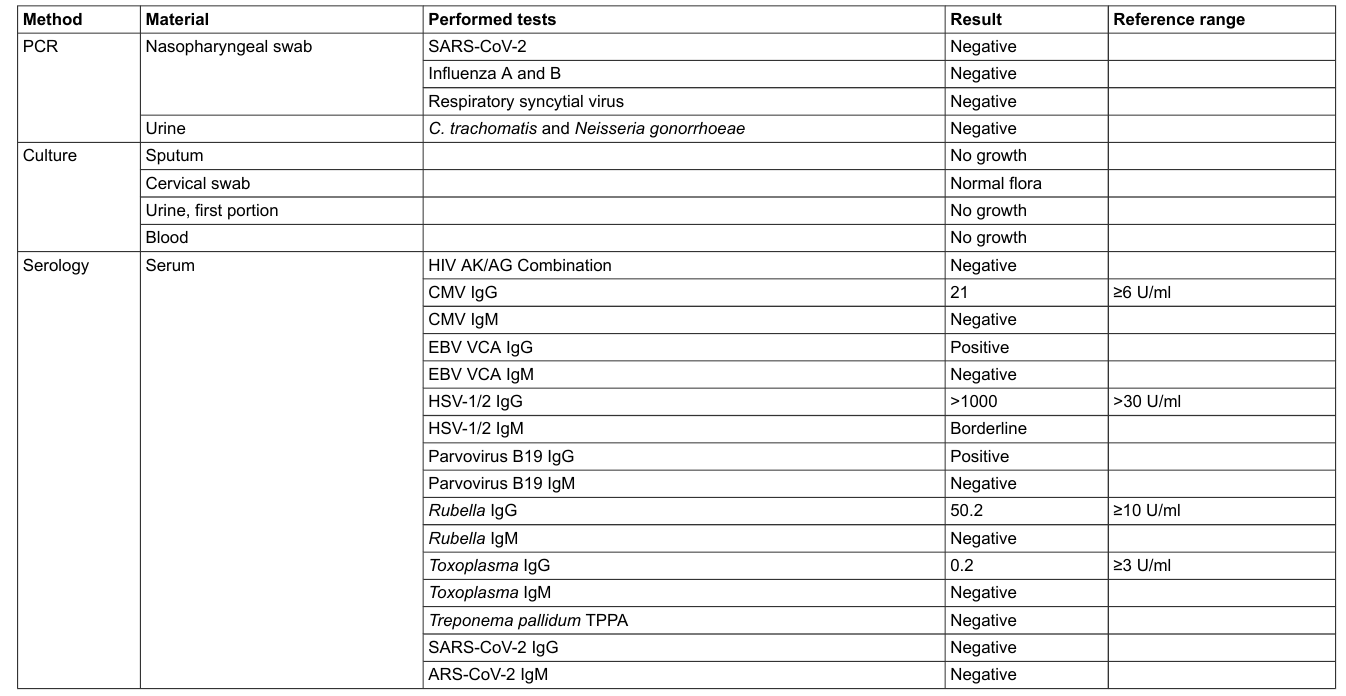
Table S3: Patient 2: Additional diagnostic findings (final diagnosis: pneumonia due to Chlamydia abortus